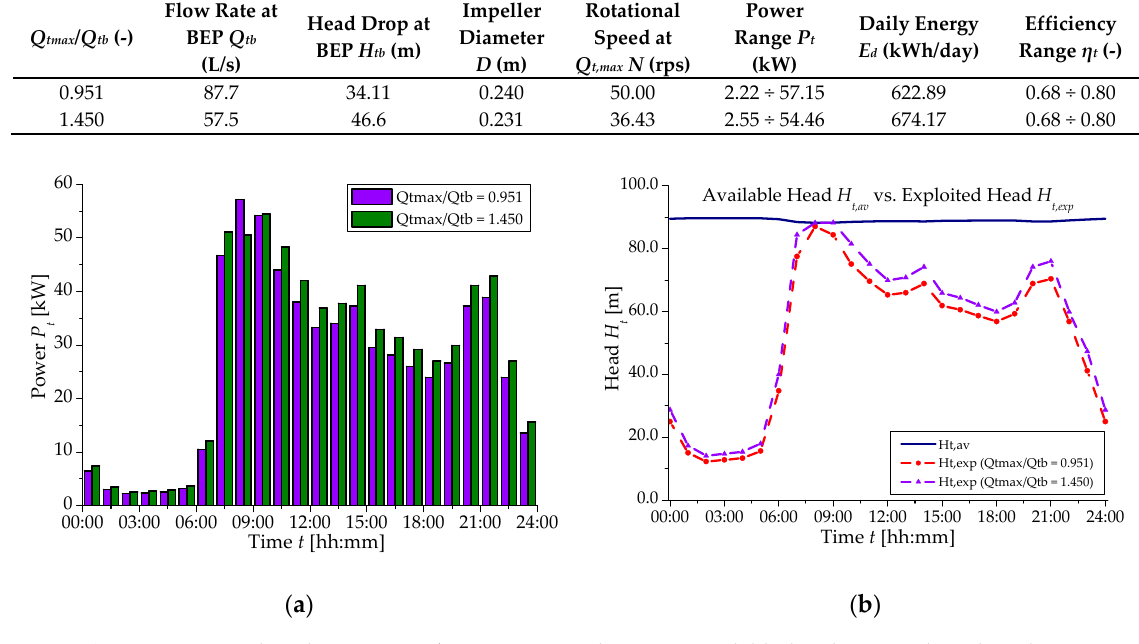
Figure 3. ( a ) Produced power P t ; ( b ) Comparison between available head H t,av and exploited one H t,exp —Scenario 2.